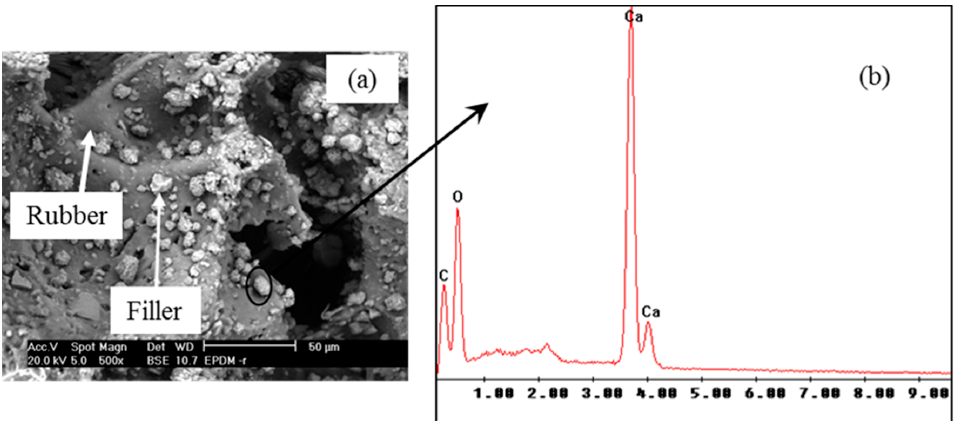
Figure 3. ( a ) SEM micrograph of EPDM-r and ( b ) Energy Dispersive Spectroscopy (EDS).